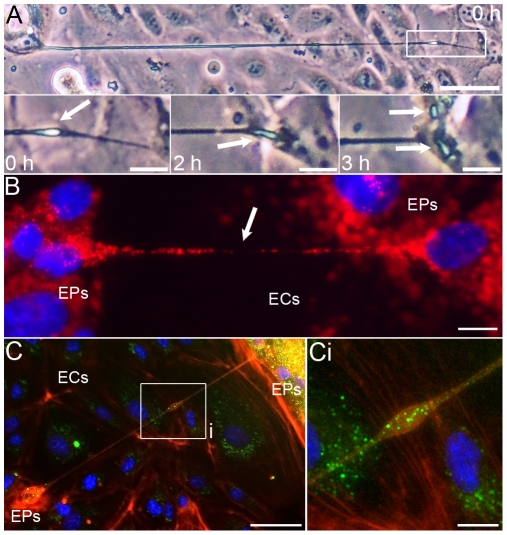
Possible transfer of cellular components via EP bridges.
A: Time lapse light microscopy in EPs/ECs of a bleb-like structure, possibly a vesicle, moving through an EP bridge and splitting once within the EP island, arrows indicate vesicle position over 3 h. B: Lysosome (red) and nucleus (blue) staining in EPs/ECs of an EP bridge connecting two cells. C: Vesicle-like structure (Ci) within an EP bridge in EPs/ECs immunostained for F-actin (red) and a Golgi apparatus marker (green), but did not stain for the presence of DNA (blue). Scale bars: (A 0 h, C), 50 µm; (A subpanels, B, Ci), 10 µm.